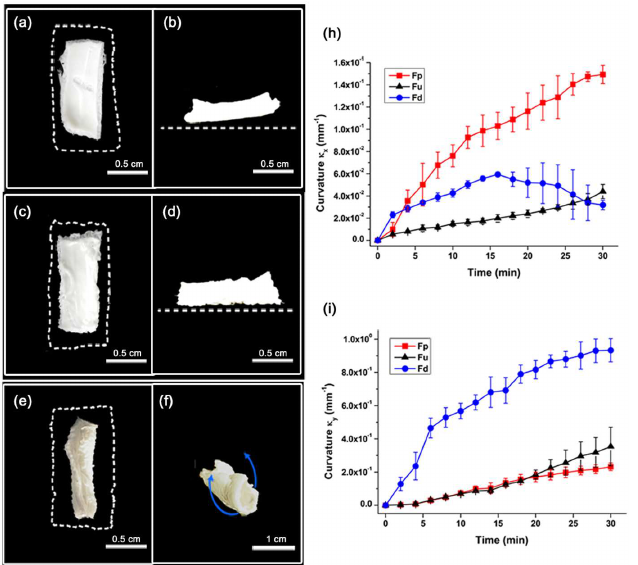
Fig 4. Motion of various layered structures(a-b). The pine cone inspiredmodel (Fp) lifts up its body after heating. (a) The structural changeof Fp is observedin the top view and white dash lines representsthe initial size of the structure. (b) The lifting heightis clearly shown in the side view. (c) Heterogeneous (C1-C3-C1) triple layers (Fu) becomes crinkly in response to heating. (d) One side is slightly lifted. (e-f) After heating, the topless structure (Fd) rolls up. Thus, the structure is capableof bendingin both directions. (h-i) Temporal variations of the curvature in the x-direction and y-directionsduring heating. (h) The Fp structure bendsthe most in the x-direction comparedto other structures. (i) The Fd structure bendsthe most in the y-direction. Howeverits asymmetric structure wouldnot allow it to bendaccordingto the directionof the temperature gradient, which Fp and Fu structures are